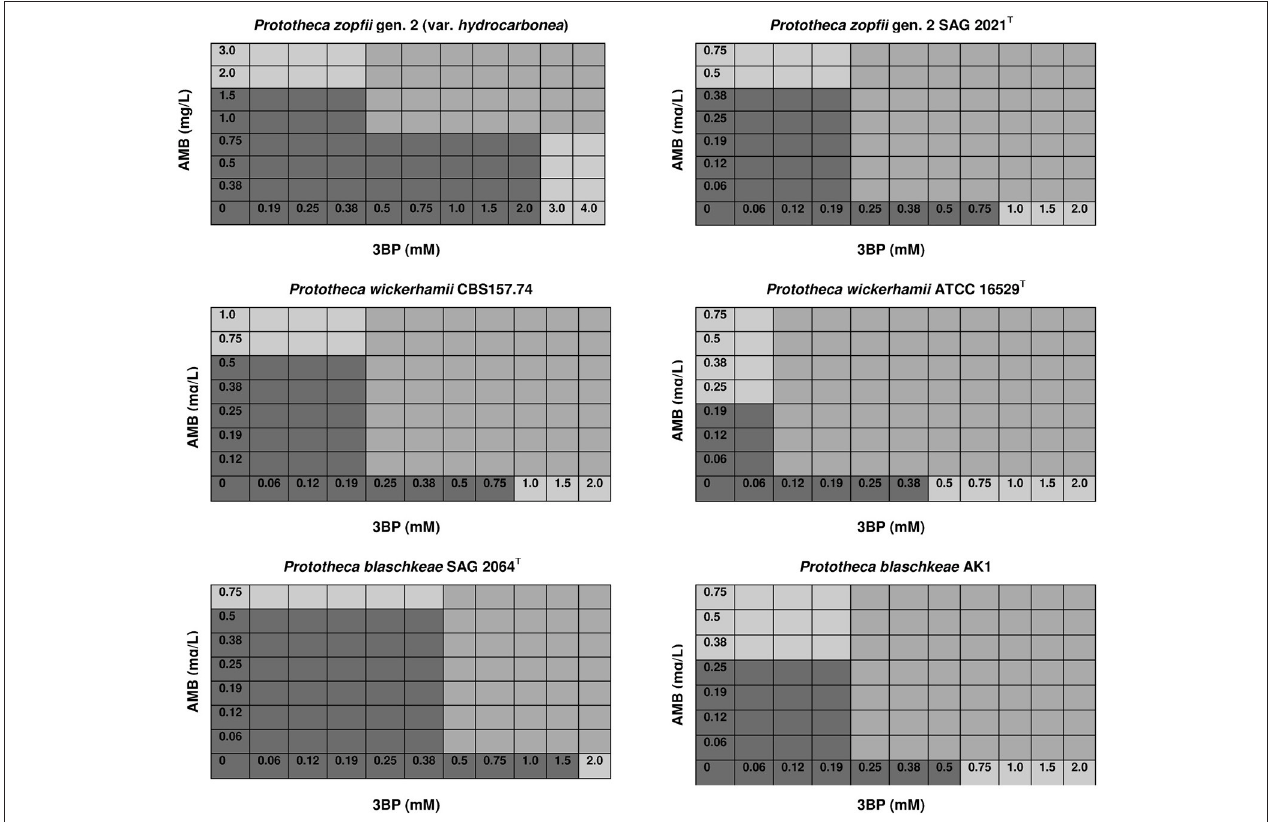
FIGURE 2 | Effective concentrations of 3BP and AMB used in combination that inhibit growth and proliferation of cells of different Prototheca spp. (mod-gray color) and not effective when used solely (dark gray color)—selected